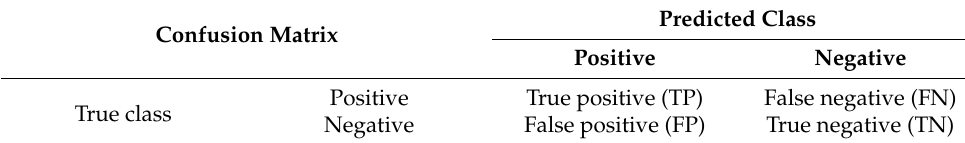
Table 3. Confusion matrix for the binary classification